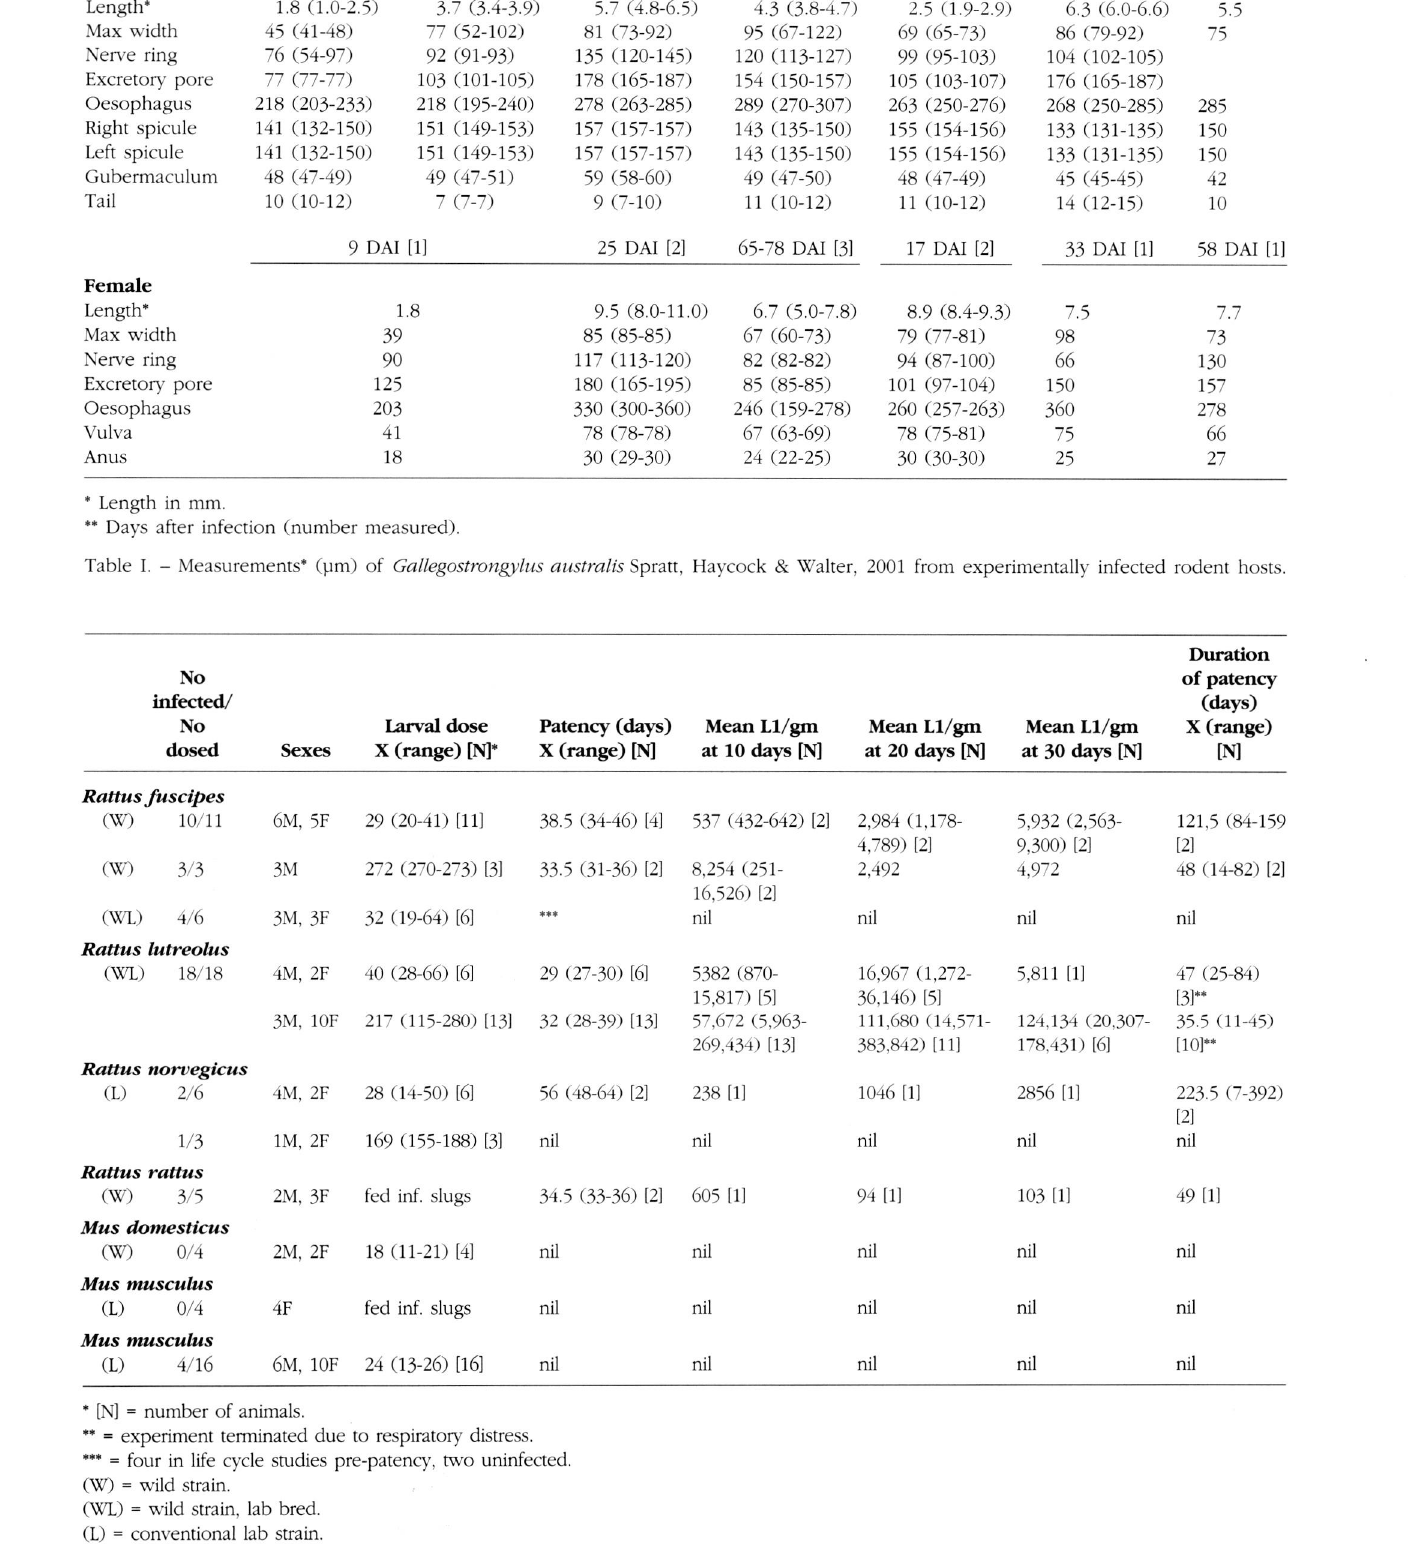
Table II. - Results of experimental infection of murid hosts with Gallegostrongylus australis Spratt, Haycock & Walter, 2001. Parasite, 2001, 8,